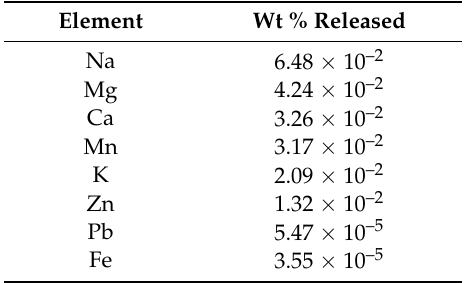
Table 5. Percentage of release of elements after two hours in water, with constant stirring, in terms to their quantity present in zinc